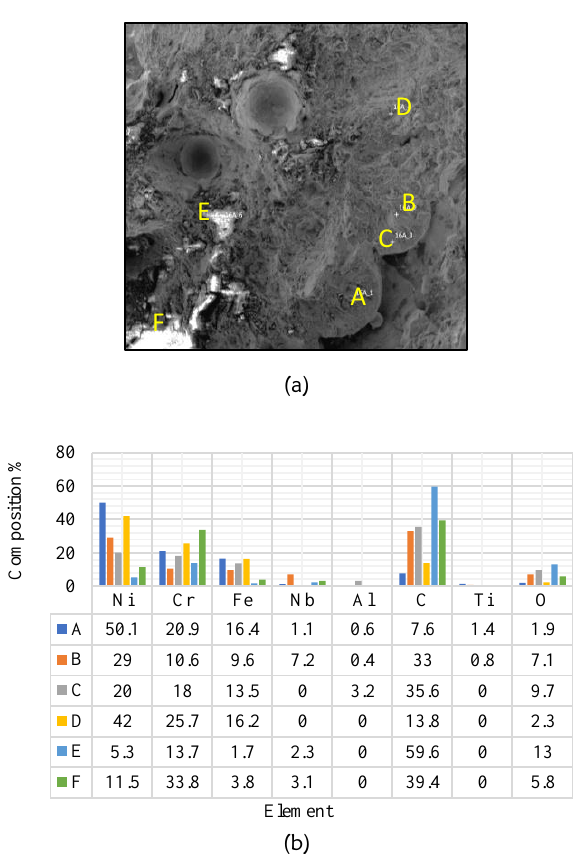
Figure 20: (a) Fractured surface of sample 16A (209.6 J/mm), and (b) EDS analysis at different locations showing high carbon